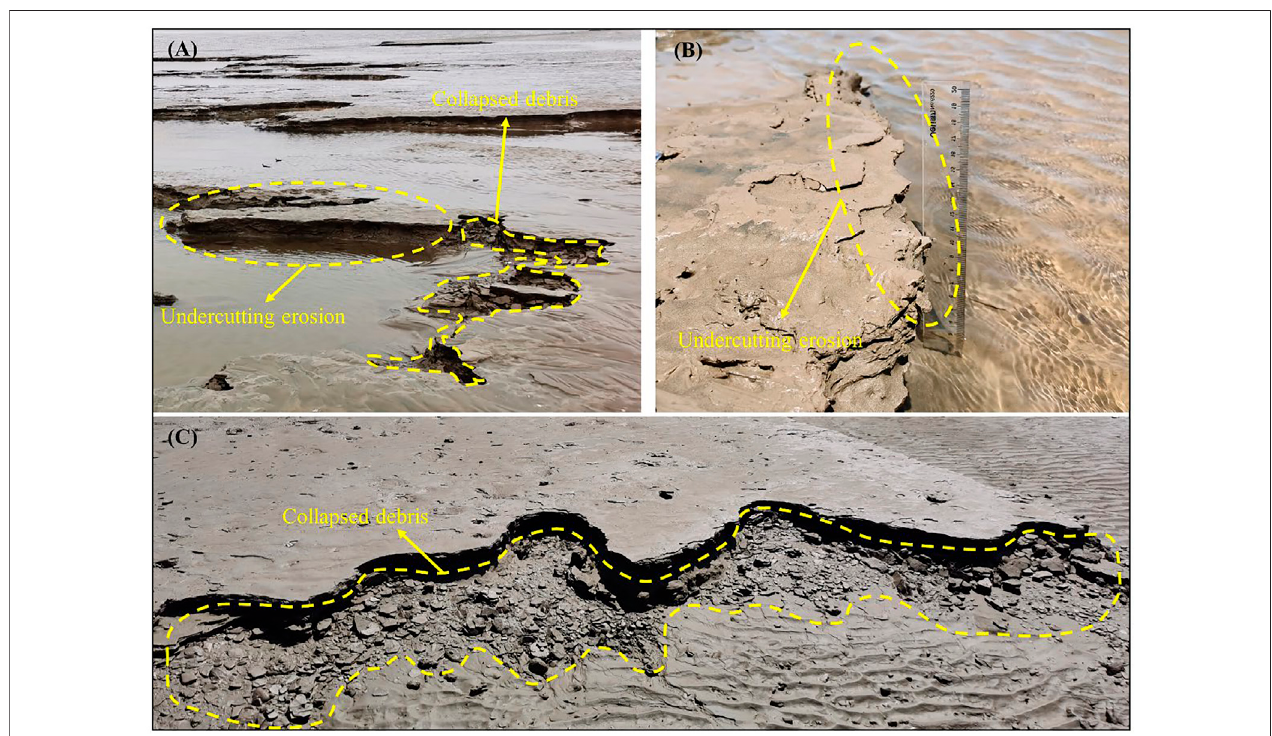
FIGURE13| Erosionandcollapsephenomenaappearduringthedevelopmentofhummockypatches. A-C arethreewell-developedpatchunitsinthemiddletidal zone, respectively. A clearly shows the developmental pattern of undercutting erosion and upper sediment debris collapse of the patch; B,C show the undercutting erosion and debris collapse stages of the patch during development,